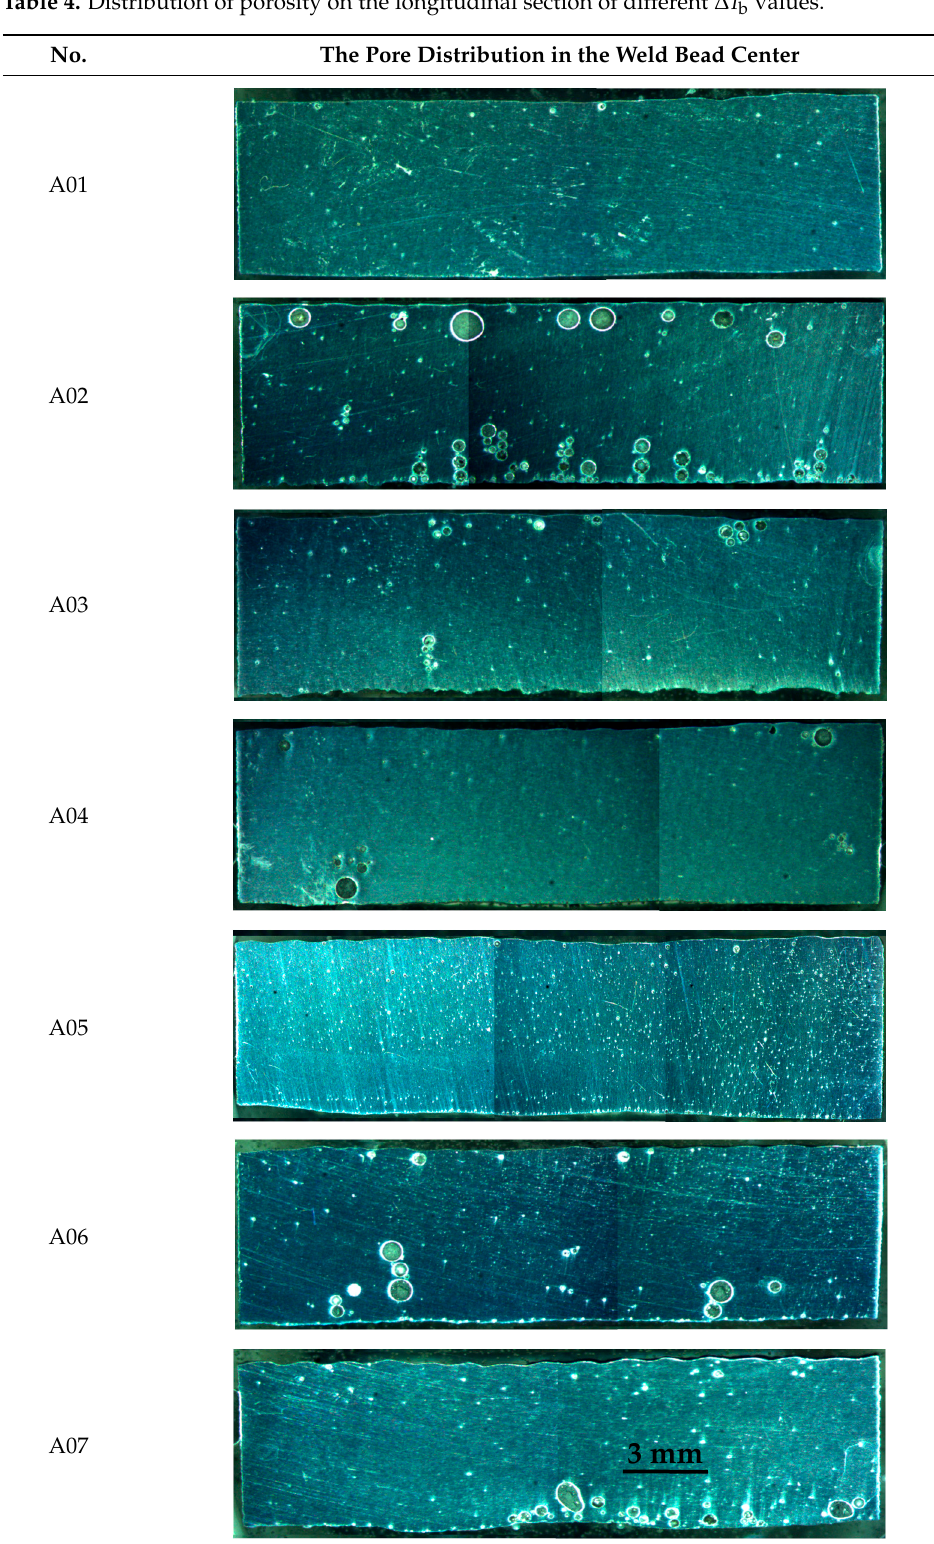
Table 4. Distribution of porosity on the longitudinal section of different ∆ I b values. No. The Pore Distribution in the Weld Bead Center